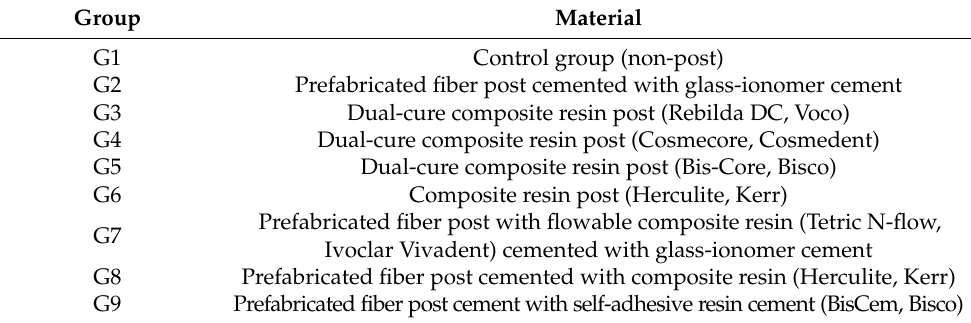
Table 1. Groups and materials used for restorative procedures. Group